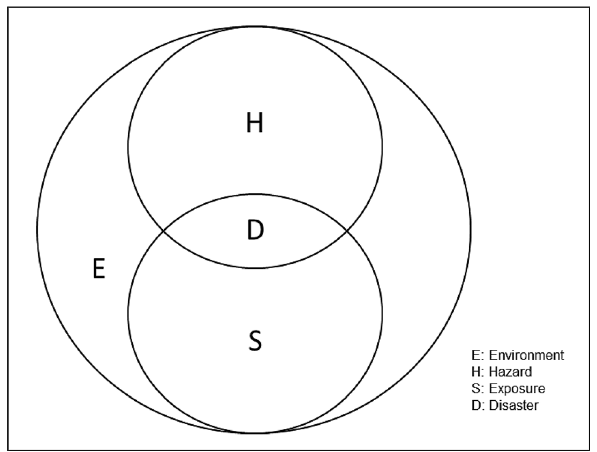
Fig. 5 The Disaster system model. Source Adapted from Shi and Kasperson